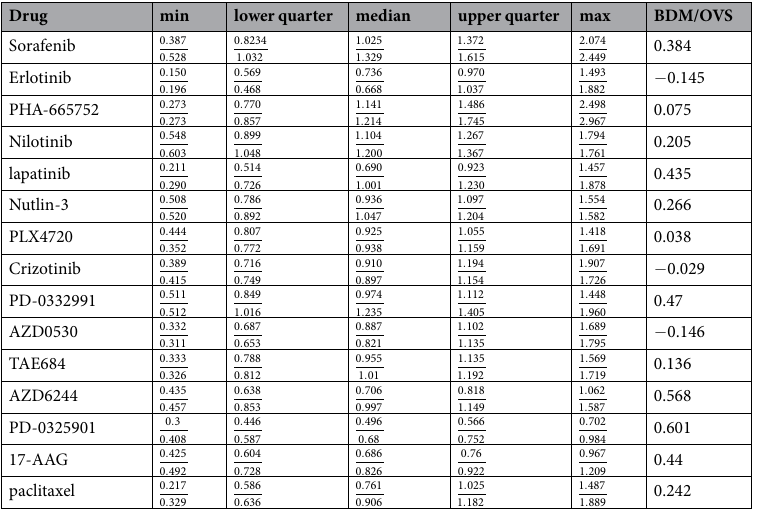
Table 2. Statistical metrics to compare test error rates from shared CCLE model (numerator) and GDSC alone model (denominator) in scenario 2 when portion of CCLE dataset was withheld as test data.